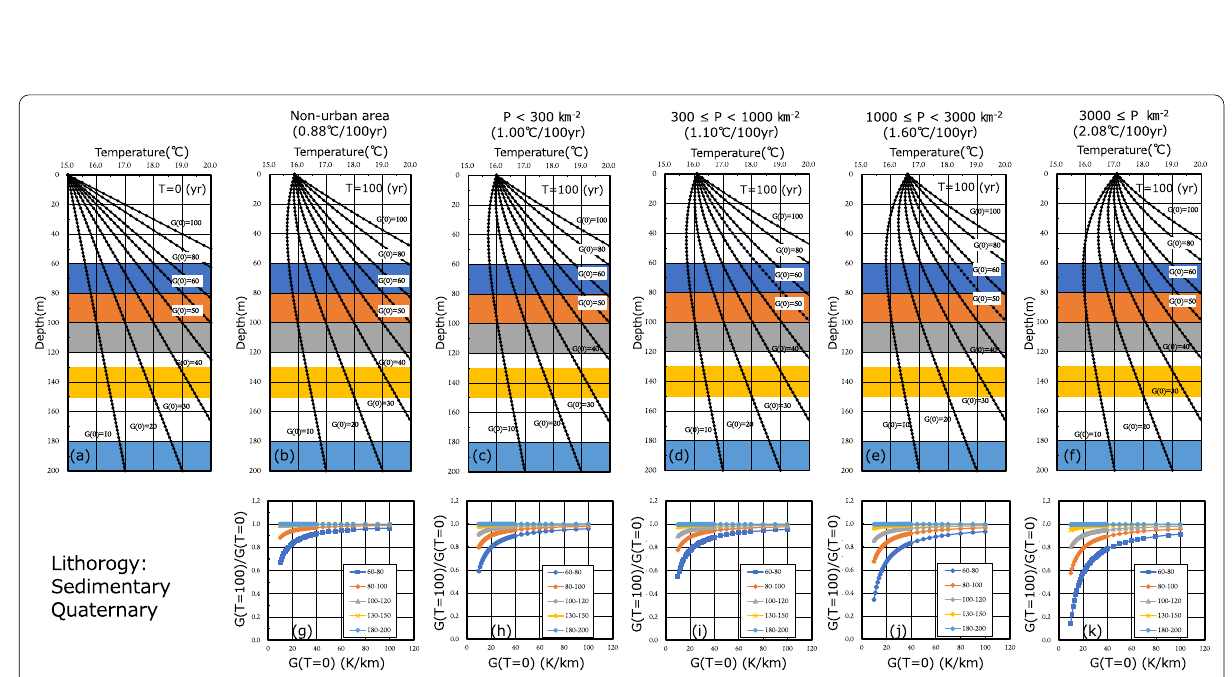
Fig. 5 Assessing the impact of climate change on temperature gradients at different depths. Changes in temperature distribution are associated with climate change. Lithology is Quaternary sediments. The composition of each figure is the same as in Fig.